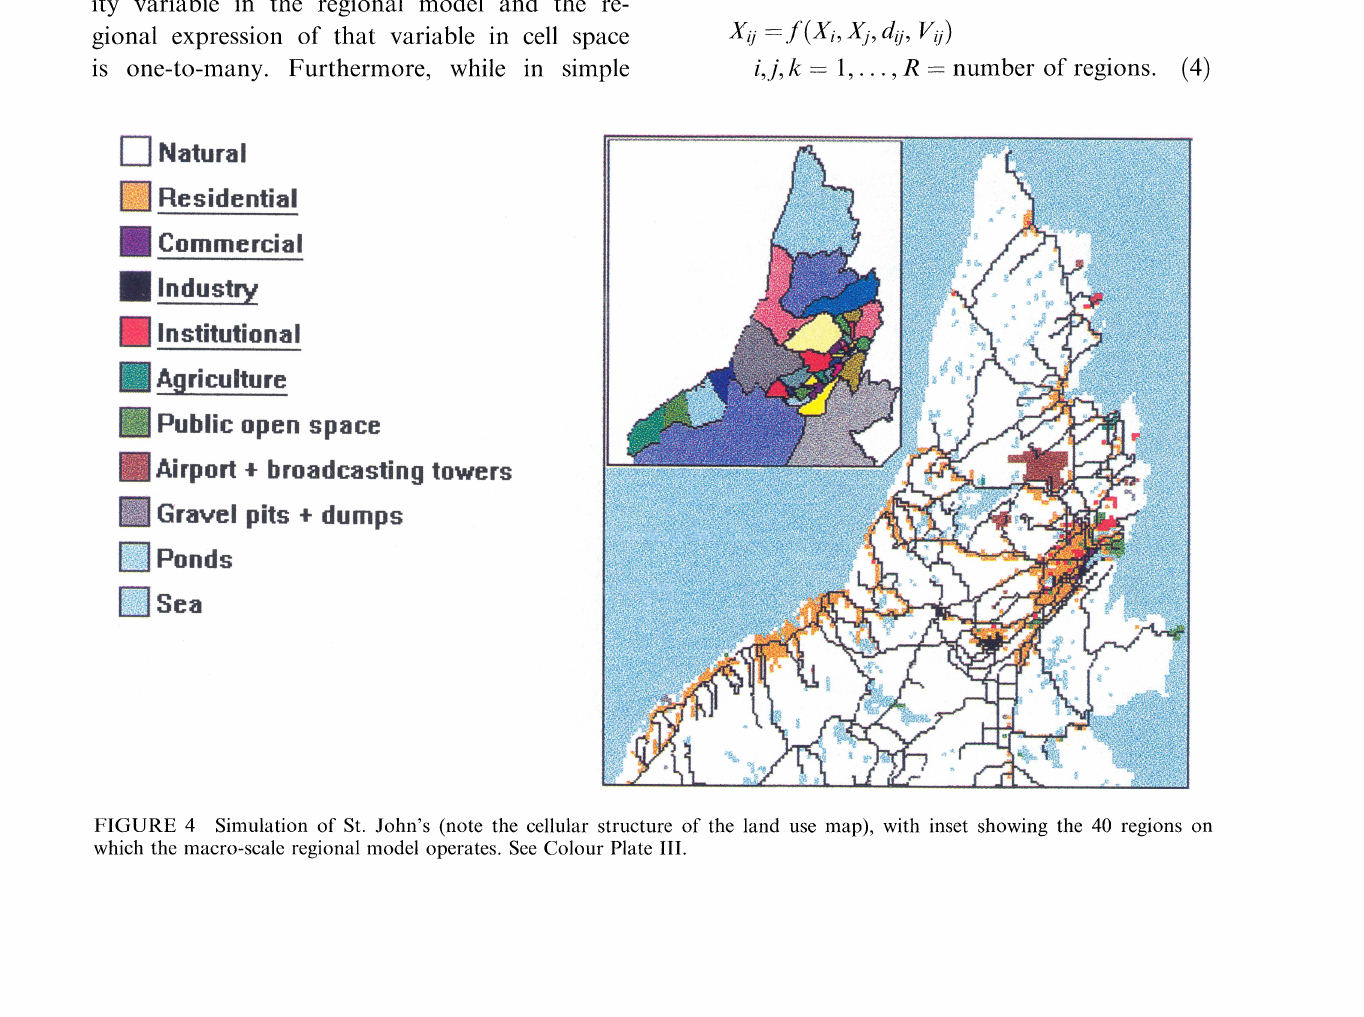
FIGURE 4 Simulation of St. John’s (note the cellular structure of the land use map), with inset showing the 40 regions on which the macro-scale regional model operates. See Colour Plate